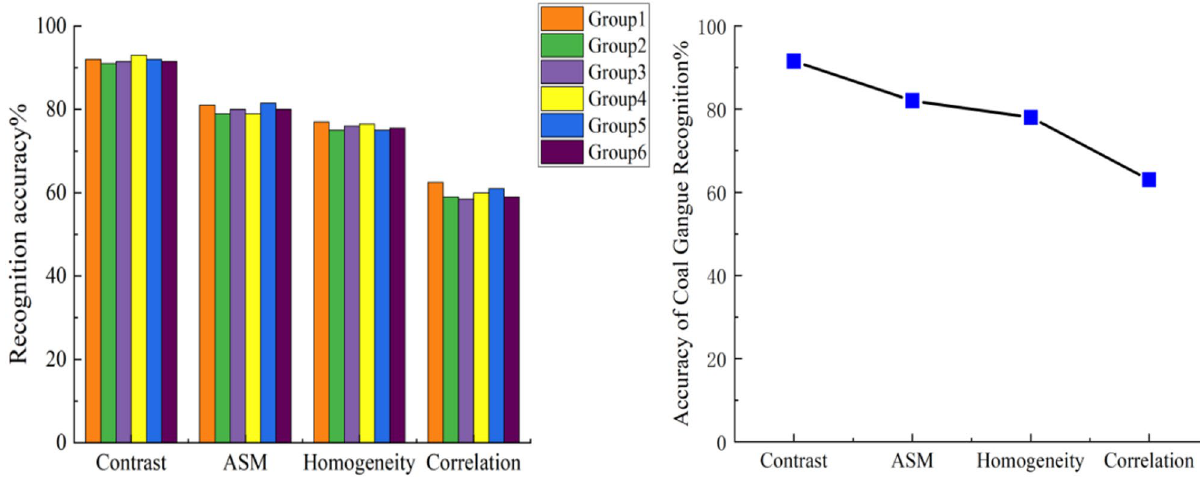
Figure 14. LS-SVM classifier recognition results based on texture